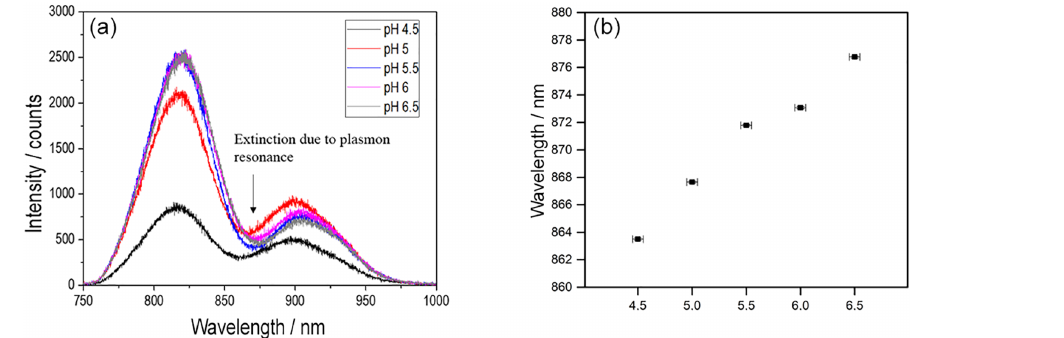
Figure 2. (a) Transmittance spectra and (b) plasmon resonance wavelengths for swelling states of the pH-sensitive hydrogel for pH values between 4.5 and 6.5.